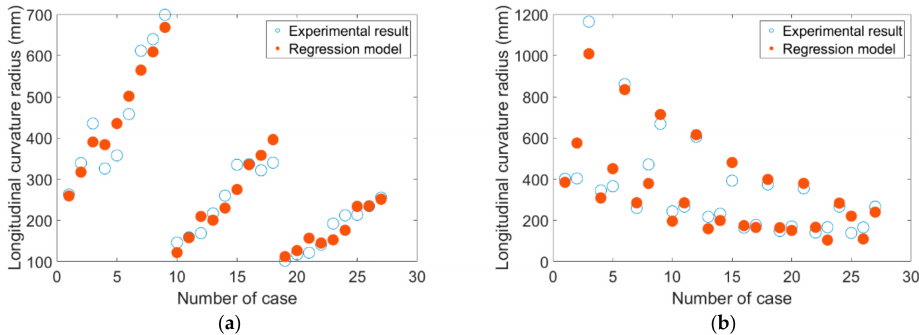
Figure 9. Di ff erence between the original and estimated data. ( a ) Convex shape and ( b ) saddle